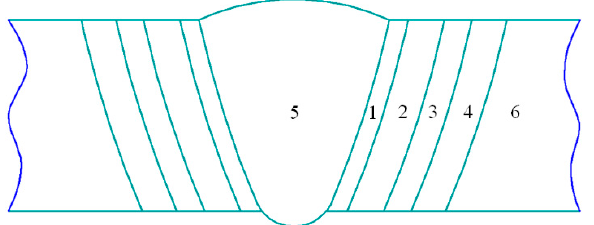
Figure 8. Scheme of HAZ Sections: 1—fusion section, 2—overheating section, 3—normalization section, 4—incomplete recrystallization section, 5—weld metal, 6—base metal.